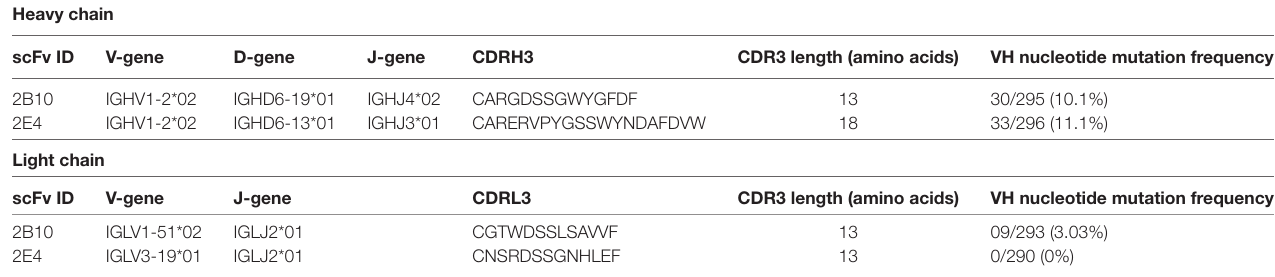
TaBle 2 | The heavy and light chain gene sequence analysis of identified anti-CD4bs scFv clones.